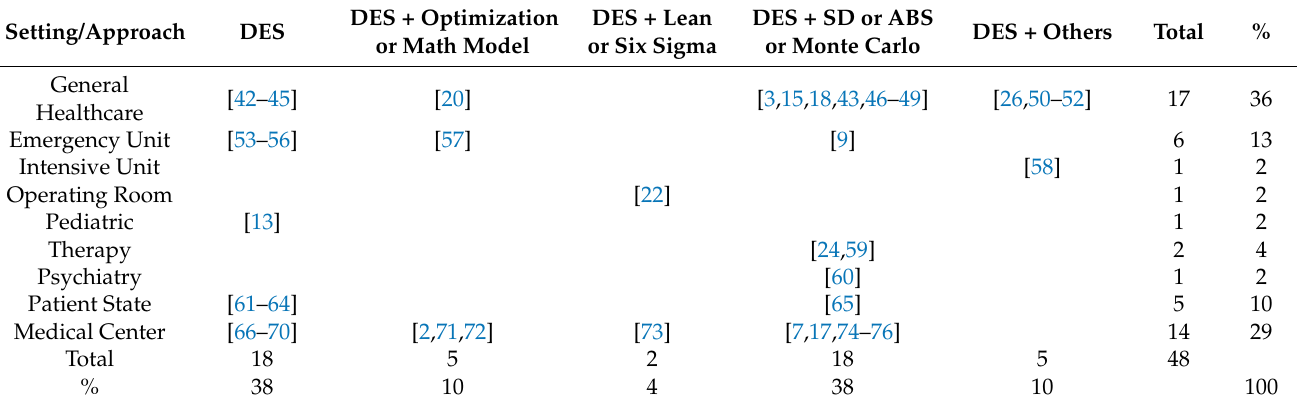
Table 3. Discrete-event simulation theoretical and conceptual papers in the literature.